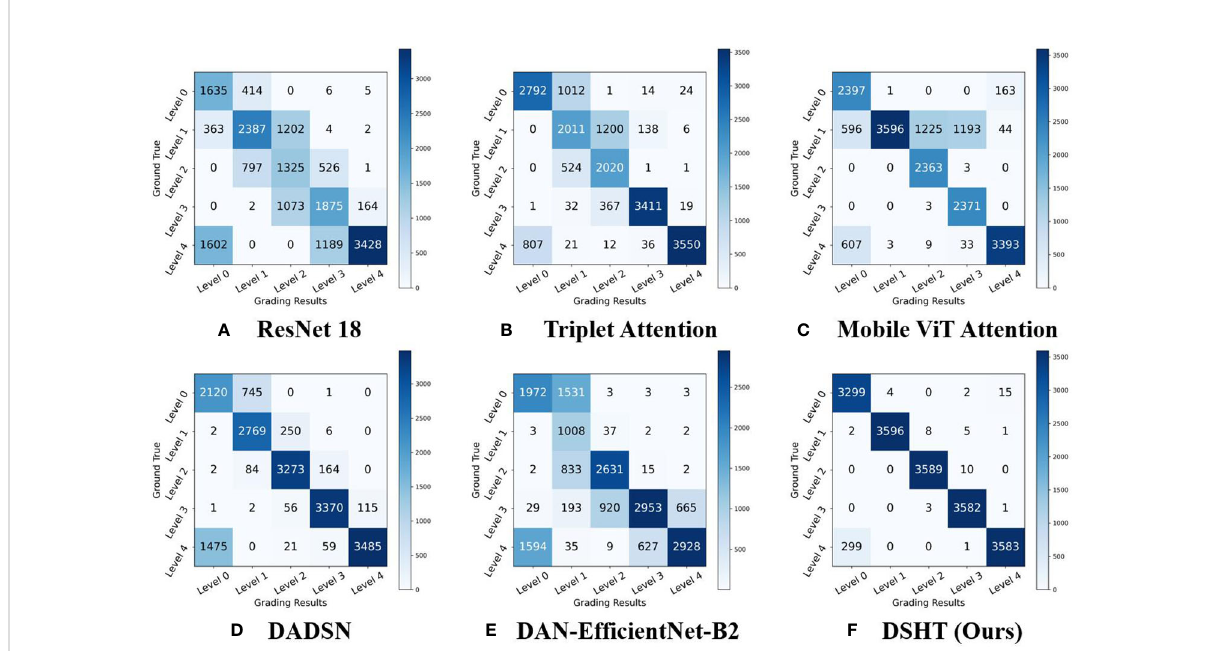
FIGURE 6 The Confusion Matrix. The experimental results of each model mentioned in Table 4 are shown, from (A – F) , for ResNet 18, Triplet Attention, Mobile ViT Attention, DADSN, DAN-Ef fi cientNet-B2, and DSHT (Ours). In the fi gure, each row represents the grading result of the model, and each column represents the true sample category. For example, in A, the fi rst column of the fi rst row indicates that: 1635 samples were grading correctly (true class L0 and graded result L0); the second column of the fi rst row indicates that: 414 samples with true class L1 were graded as L0 by ResNet; the fourth column of the fi rst row indicates that: 6 samples with true class L3 were graded as L0 by ResNet; the fi rst column of the second row indicates that: 363 samples with true class L0 are graded as L1 by ResNet.